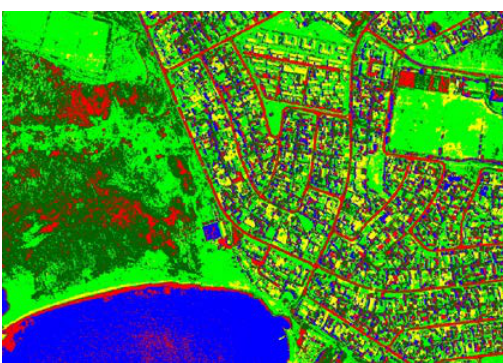
Figure 3: Results of unsupervised classification – ISODATA method – 12 classes